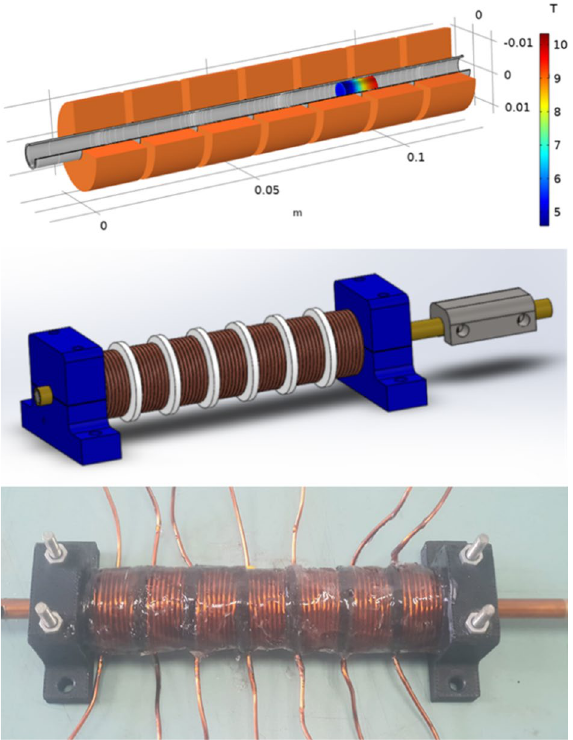
Figure 9. Structure of the 7 stage coilgun, the electromagnetic simulation, the mechanical model, and a picture of the constructed